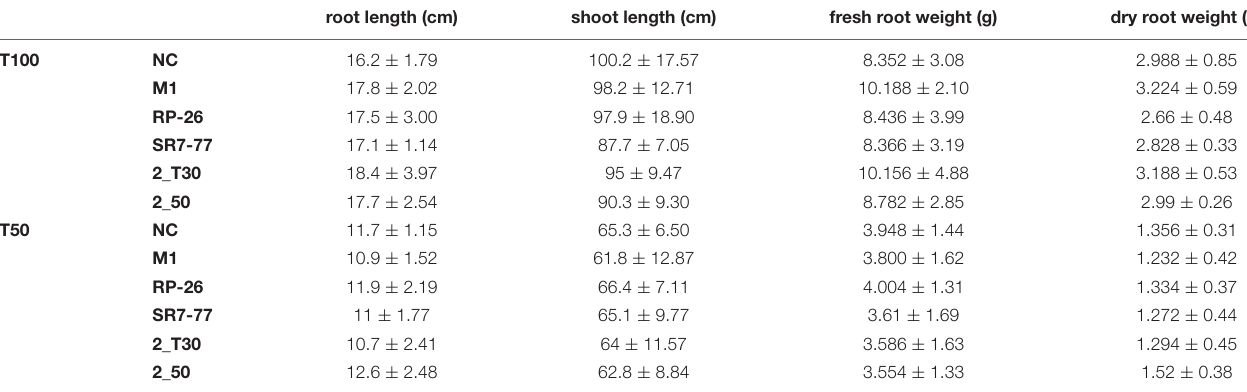
TABLE 2 | Effect of PGP bacteria inoculation on plant growth under full irrigation condition (T100) and water stress (T50). root length (cm) shoot length (cm) fresh root weight (g) dry root weight